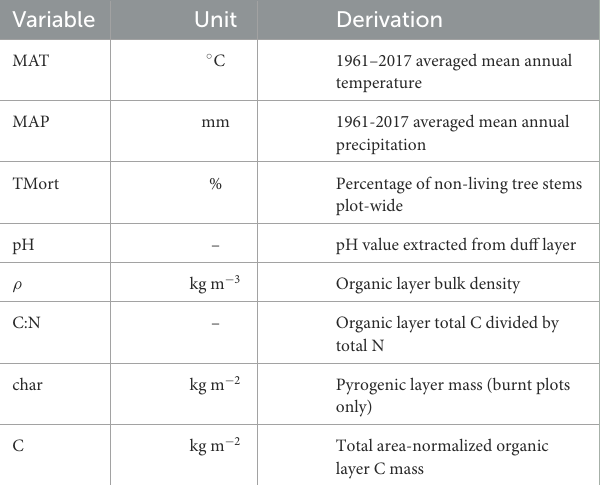
TABLE 1 All climate and forest property predictor variables used in analysis with units and description of their derivation.